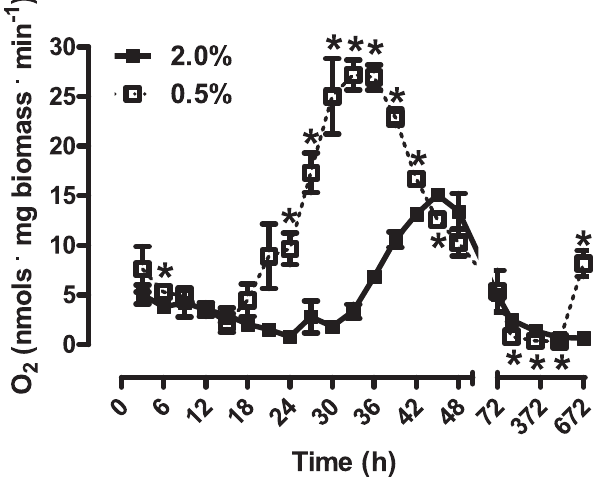
Figure 1. Oxygen consumption rates vary during WT S. cerevisiae chronological lifespan. Intact cellular respiratory rates of WT S. cerevisiae cultured in 2.0% glucose ( & ) or 0.5% glucose ( % ) were measured as described in Materials and Methods . * p , 0.05 vs. 2.0% WT (unpaired Student’s t test).